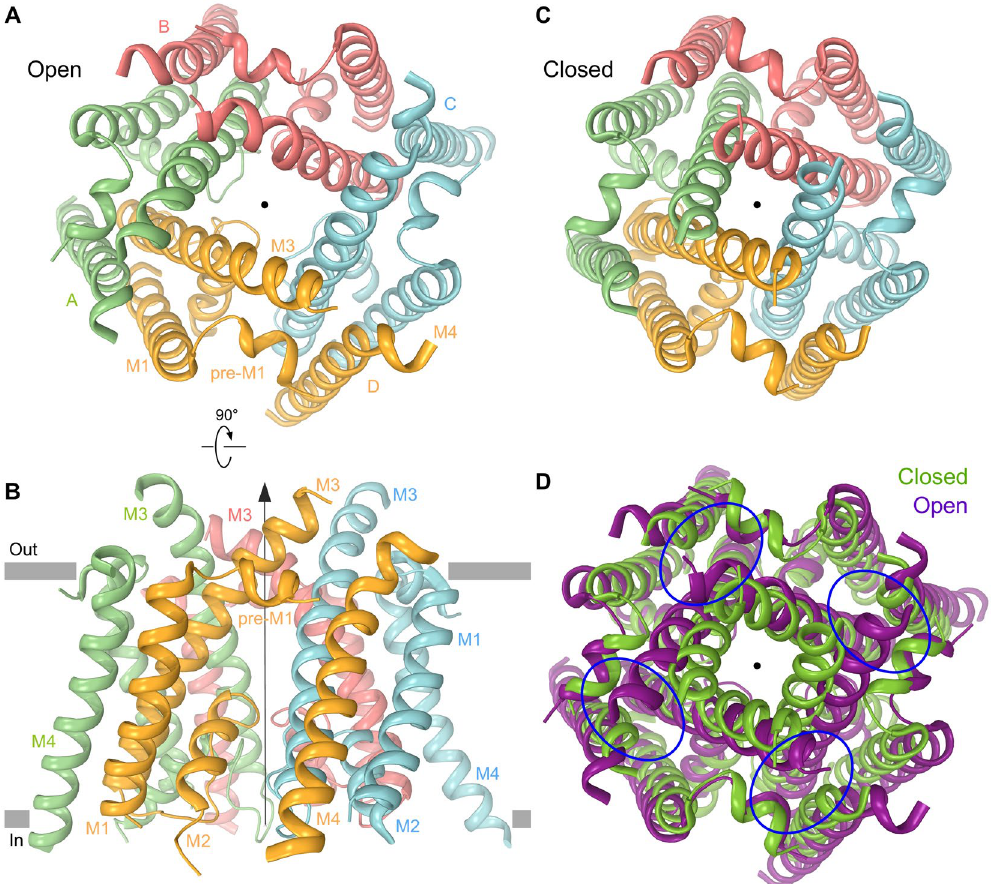
Figure 5. MD simulated ion channel open state. ( A , B ) MD simulated structure of GluA2 ion channel in the open state (see Methods and text) viewed extracellularly ( A ) or parallel to the membrane ( B ). The pore axis is illustrated by a black arrow. ( C ) Closed channel from GluA2 apo structure (PDB ID: 5L1B) viewed extracellularly. ( D ) Superposition of the ion channel open (purple) and closed (green) conformations from ( A and B ) respectively. Blue ovals designate the noncompetitive inhibitor binding